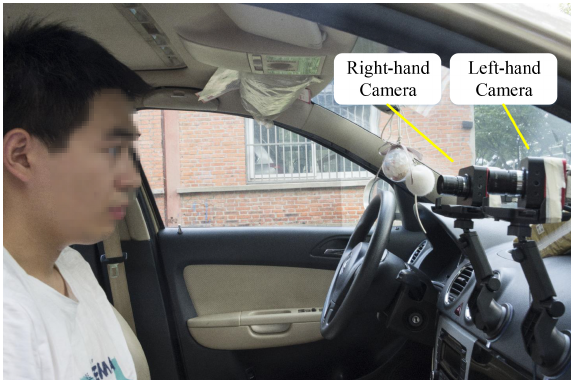
Figure 11. On-board image acquisition system.